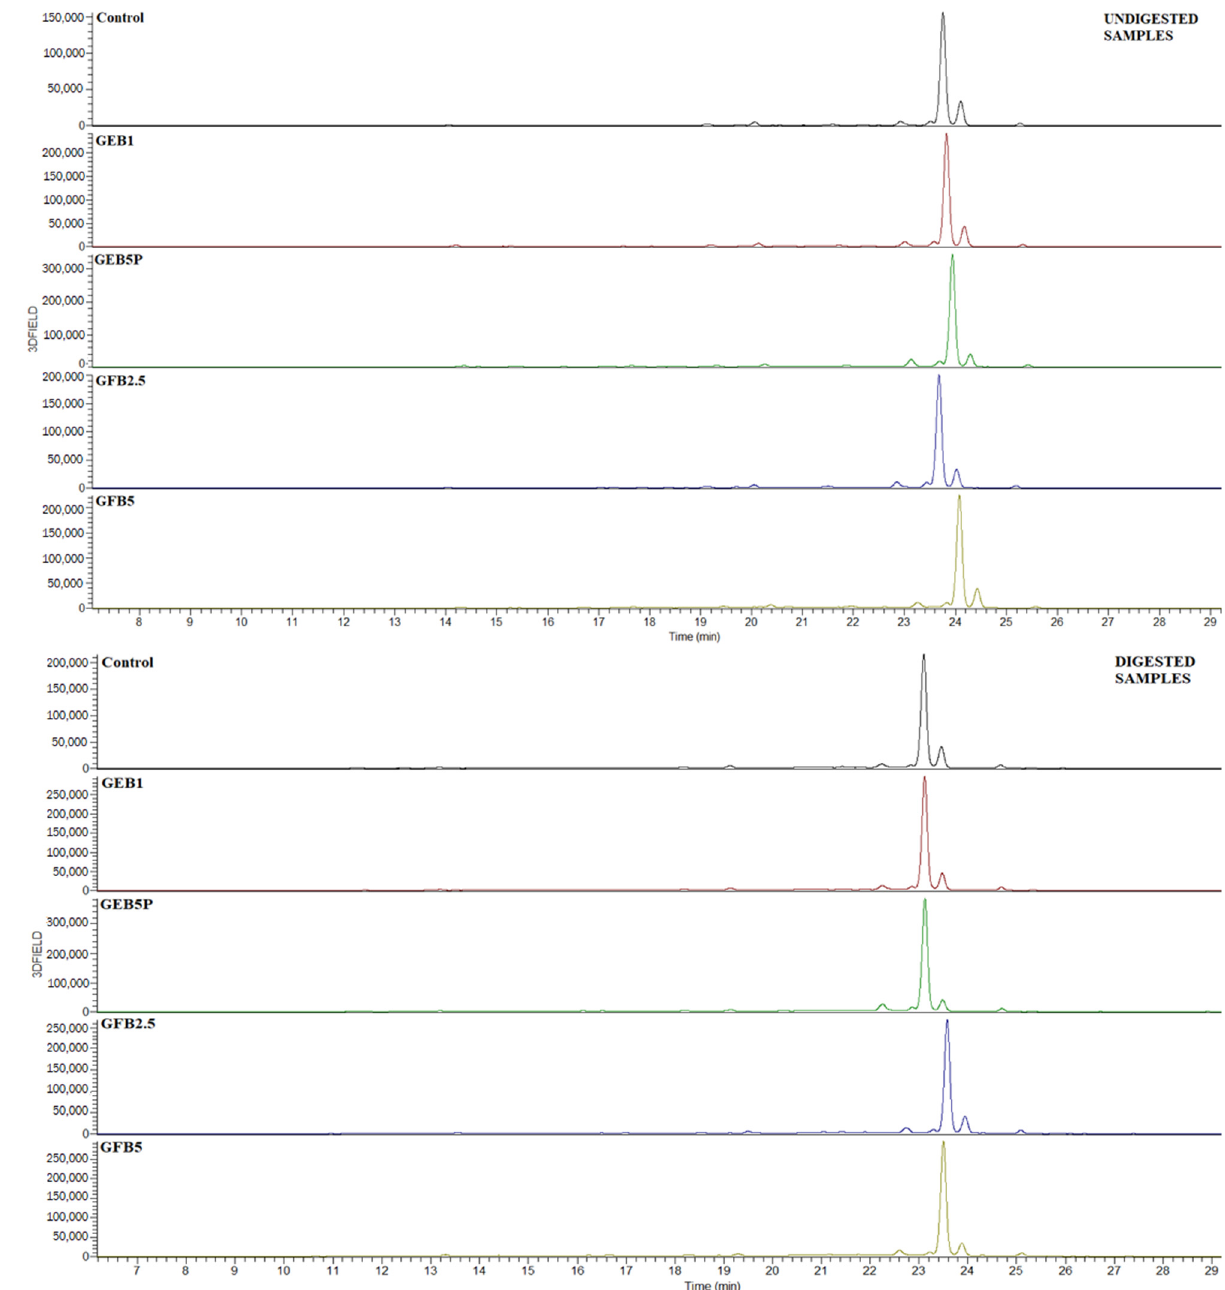
Figure 2. HPLC chromatograms of bound phenolics before and after in vitro digestion of control and bioprocessed breads. Detection was achieved at 310 nm. Control: wheat bread with no added bioprocessed flour; GEB1: wheat bread enriched with 1% “germinated + enzymatic treated” spelt flour; GEB5P: wheat bread enriched with 5% pasteurized “germinated + enzymatic treated” spelt flour; GFB2.5: wheat bread enriched with 2.5% “germinated + fermented” spelt flour; GFB5: wheat bread enriched with 5% “germinated + fermented” spelt flour.